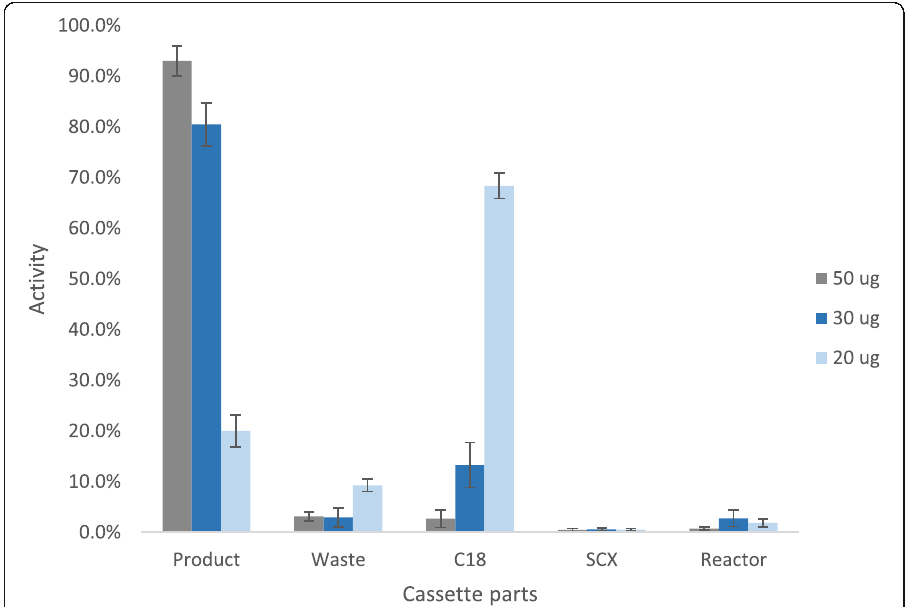
Fig. 2 Overview activity distribution [% of total] of different experiments n ≥ 3 (grey: 50 μ g; blue: 30 μ g; light blue: 20 μ